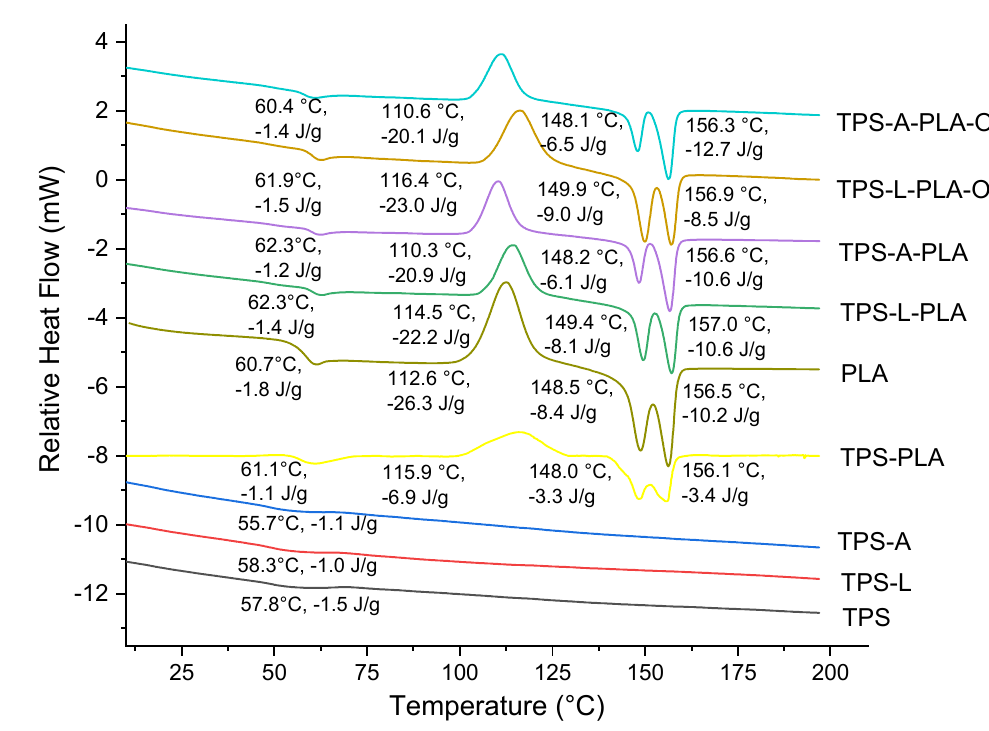
Figure 6. The differential scanning calorimetry (DSC) thermogram for TPS samples.